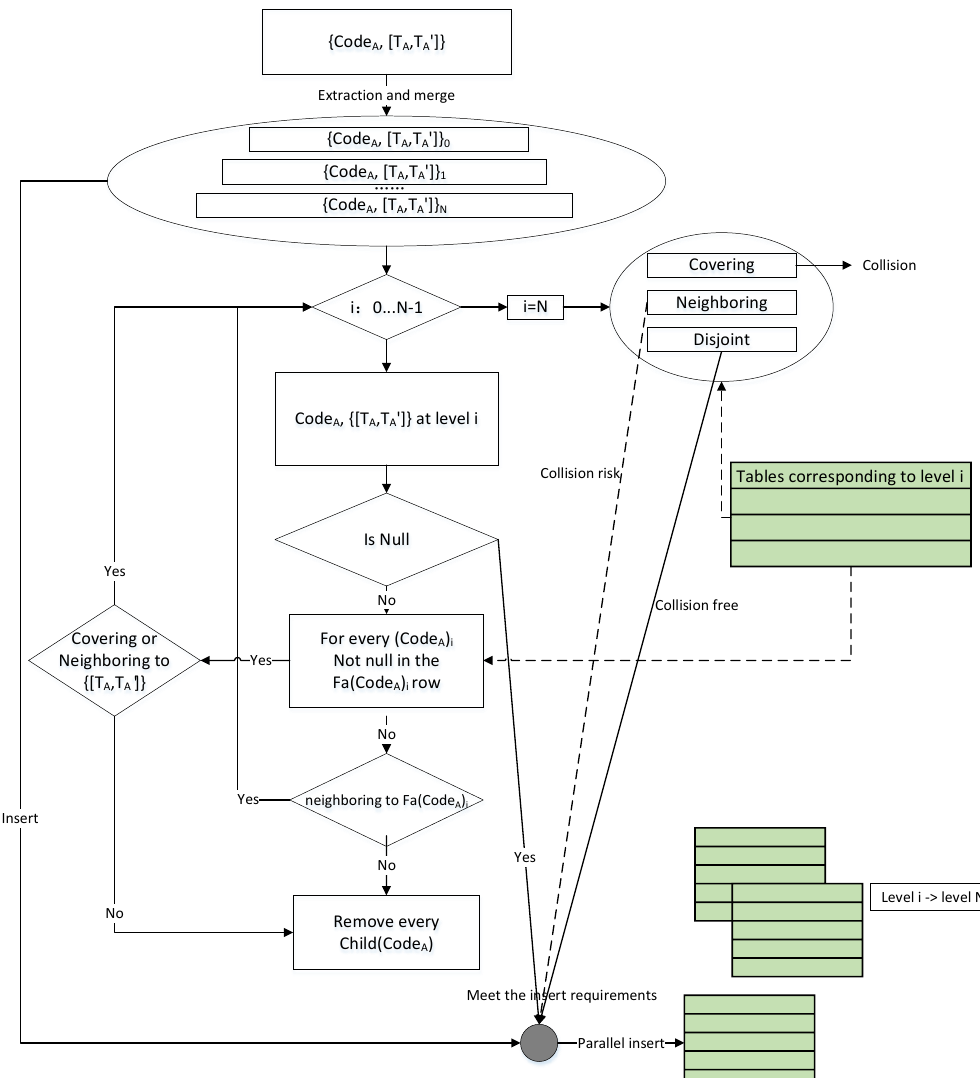
Figure 5. Collision detection for multiple grids. Multiple spatiotemporal grids are compared individually with the existing data at multiple levels. After determining the spatial relationship, the spatiotemporal grid information can be inserted into multiple data tables in parallel.